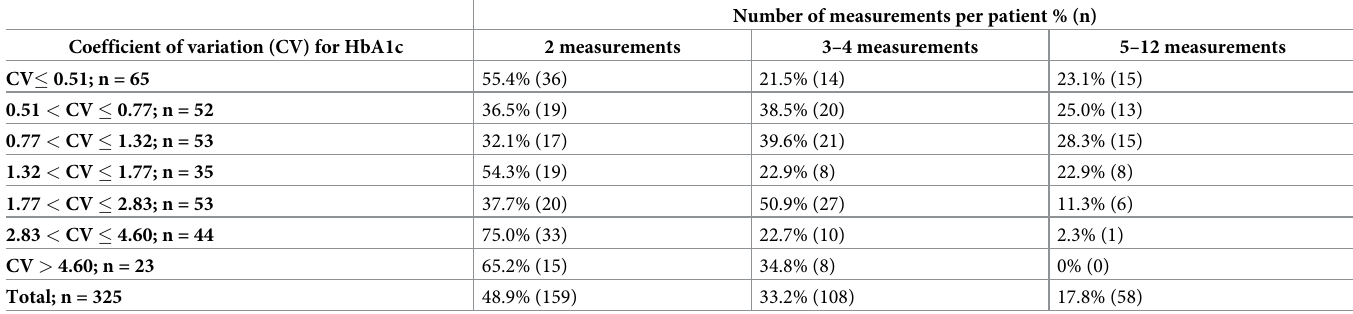
Number of measurements per patient % (n)